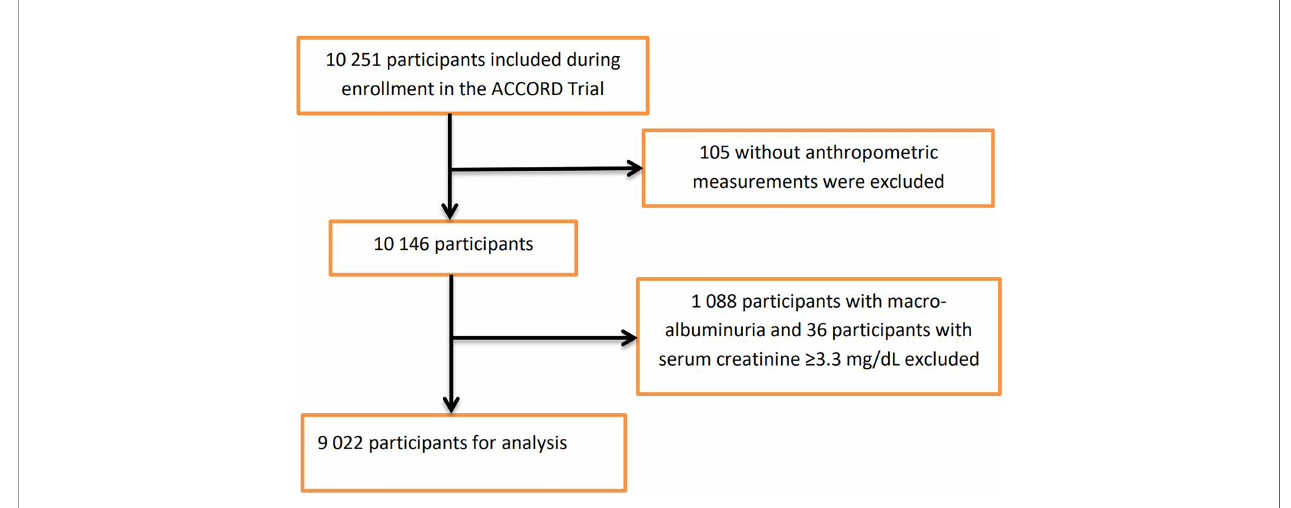
FIGURE 1 | Flowchart for participant